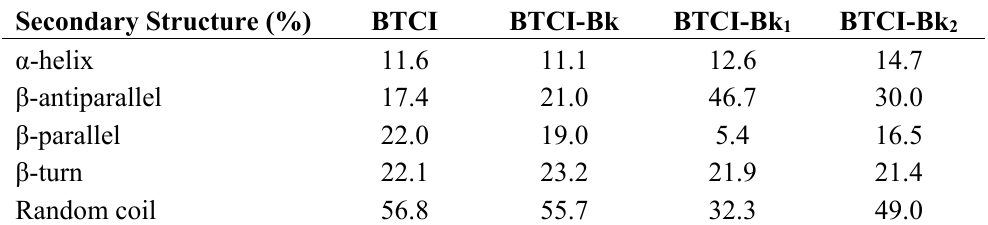
Table 4. Secondary structure contents of the BTCI and BTCI-Bk